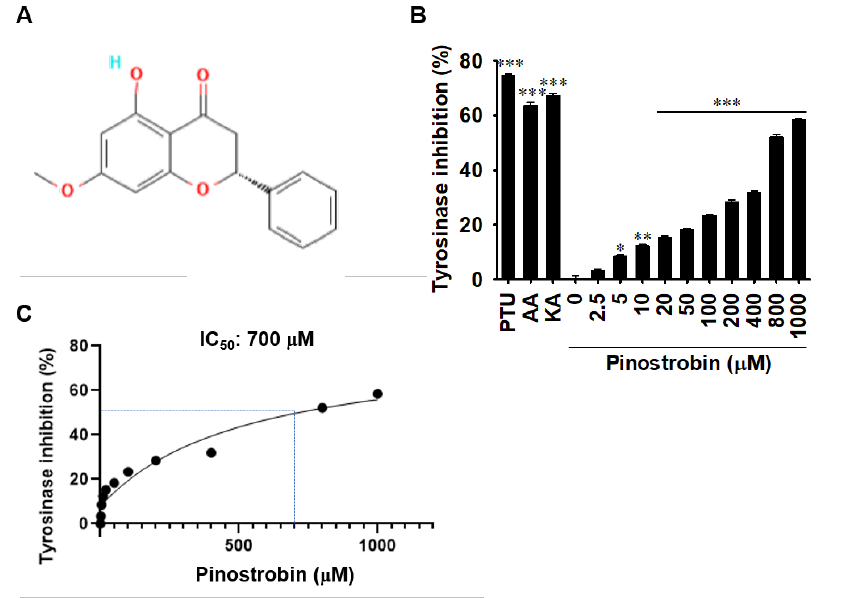
Figure 1. Pinostrobin inhibits in vitro mushroom tyrosinase activity. ( A ) Chemical structure of pinostrobin. ( B ) In vitro mushroom tyrosinase activity, as assessed by quantifying dopaquinone levels, following treatment with pinostrobin (0–1000 µ M), phenylthiourea (PTU, 250 nM), ascorbic acid (AA, 500 µ M), and kojic acid (KA, 25 µ M). Data are reported as the mean ± SE. * p < 0.05, ** p < 0.01, and *** p < 0.001 vs. untreated control. ( C ) Pinostrobin concentration required for 50% inhibition (IC 50